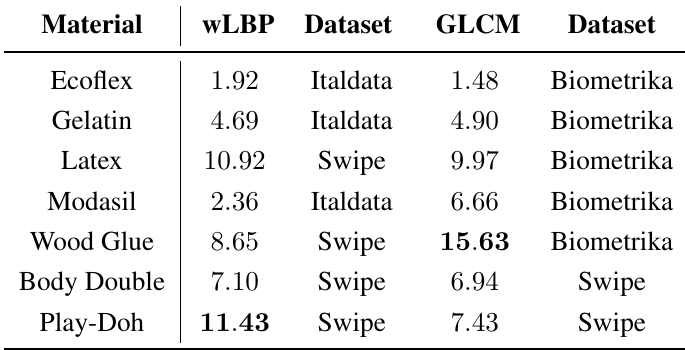
Table 6. ACER for the each type of fake mold and the respective sensor (ACER in % ). Material wLBP Dataset GLCM Dataset Ecoflex 1 .